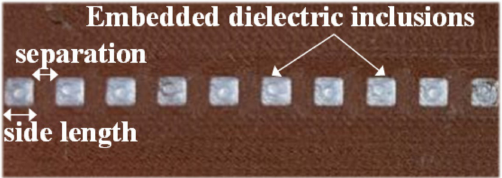
Figure 11. Permittivity contrast encoder based on embedded dielectric inclusions. The thickness of the encoders is 1 mm. Dimensions of the embedded square dielectric inclusions (in mm) are: 2.8 mm side length and 2.4 mm separation. Reprinted with permission from [30]. Copyright 2020 IEEE.